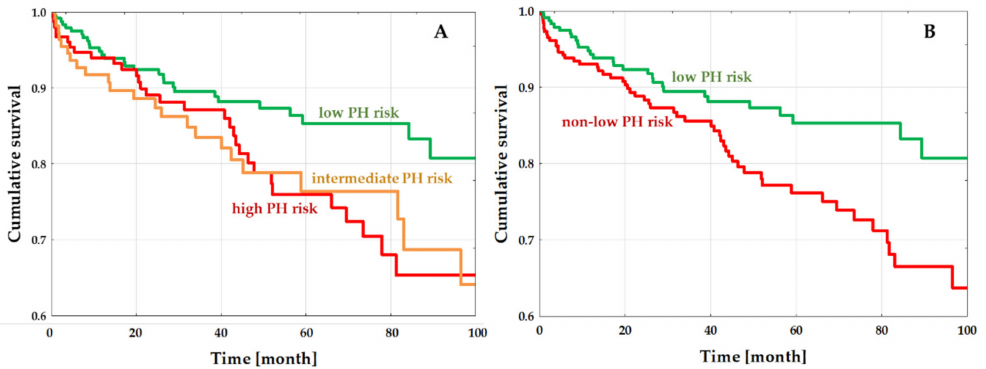
Figure 3. Kaplan–Meier estimates for all-cause mortality. ( A ) Study population divided into three di ff erent PH-risk groups. ( B ) Study population divided into low and non-low PH-risk groups. Low-risk patients had a significantly lower risk of all-cause death than high- and intermediate-, and non-low PH-risk DCM patients. Abbreviations: PH–pulmonary